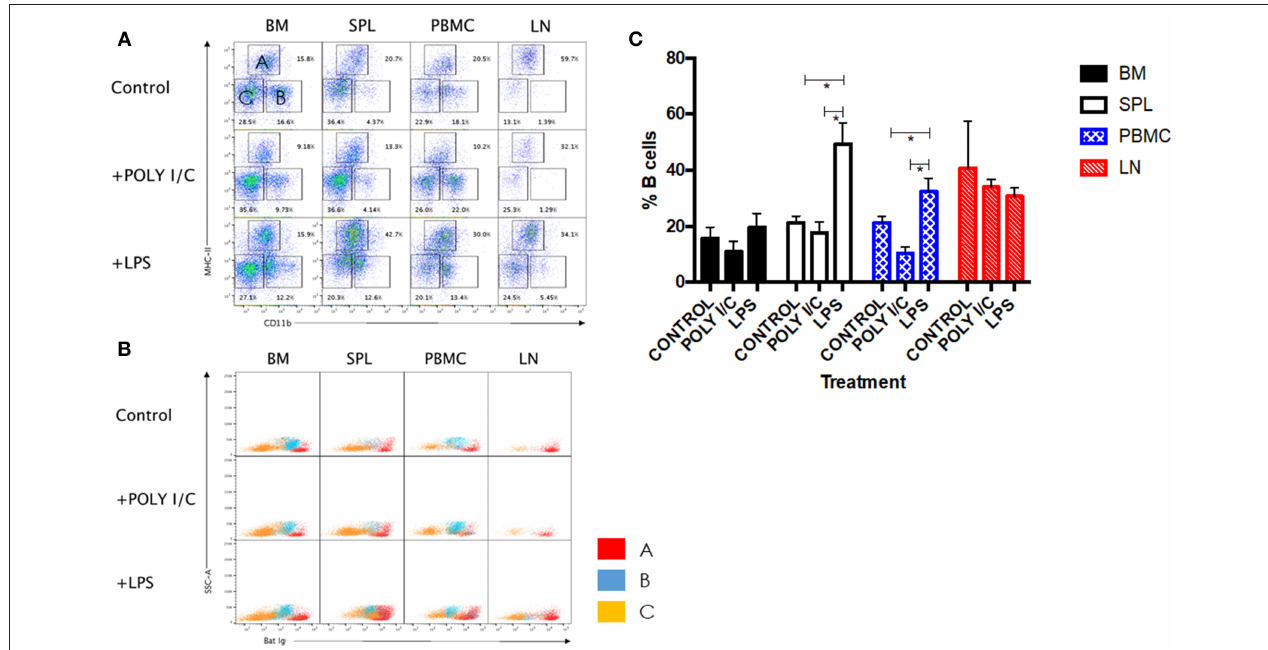
FIGURE 5 | Analysis of immune cell populations in P. alecto treated with LPS or Poly I:C. (A) Cells from the bone marrow (BM), spleen (SPL), blood (PBMC) and lymph nodes (LN) were harvested 5h after sc. injection with either LPS or Poly I:C, and analyzed by flow cytometry. Lymphocytes were gated based on forward and side scatter distribution. Three distinct populations were clearly obtained based on CD11b and MHC-II staining, namely subset A (CD11b + / − MHC-II + ), subset B (CD11b + MHC-II − ), and subset C (CD11b − MHC-II − ). Representative data for one bat is shown. (B) All three subsets were analyzed for Ig surface expression. (C) Percentages of B cells in BM, SPL, PBMC and LN from untreated, LPS treated and poly I:C treated ( n = 3) bats 5h post-treatment. Students t -test was used for the statistical analysis. * p < 0.05.